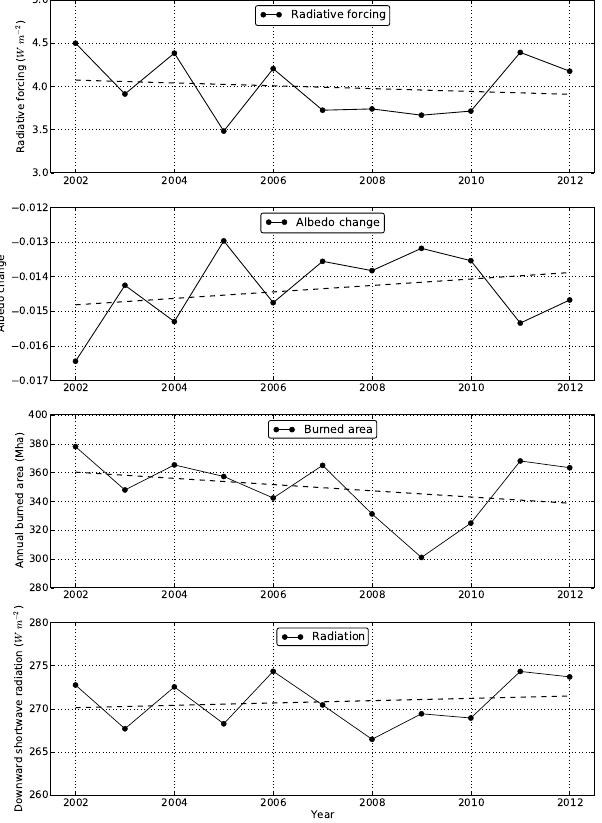
Figure 2. Temporal changes in the annual global radiative forc- ing induced by fires and albedo change spanning the years 2002 to 2012. Bottom plots show the total annual burned area and the down- ward shortwave radiation fluxes at the surface. The dashed lines depict linear trends, where changes of rate per year are, for radia- tive forcing, − 0.016Wm − 2 ; albedo change is 9.33e-05; the burned area is − 2.15Mha; and downward shortwave incoming radiation is 0.14Wm − 2